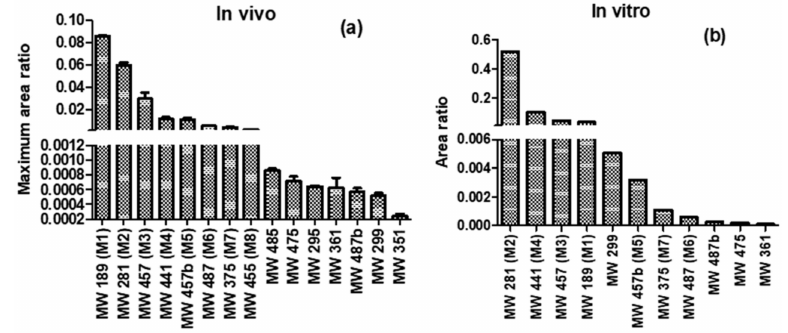
Figure 6. ( a ) The relative maximum peak area (maximum metabolite area divided by the maximum peak area of ANT) of detected metabolites in plasma after administration of ANT ( b ). The relative peak area (the metabolite area divided by the peak area of ANT) of metabolites detected after 120 min of incubation with pooled human